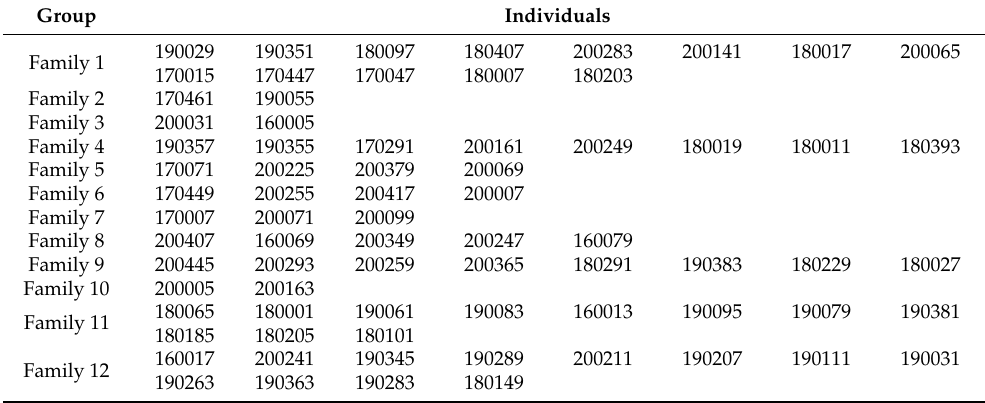
Table 4. Results of family